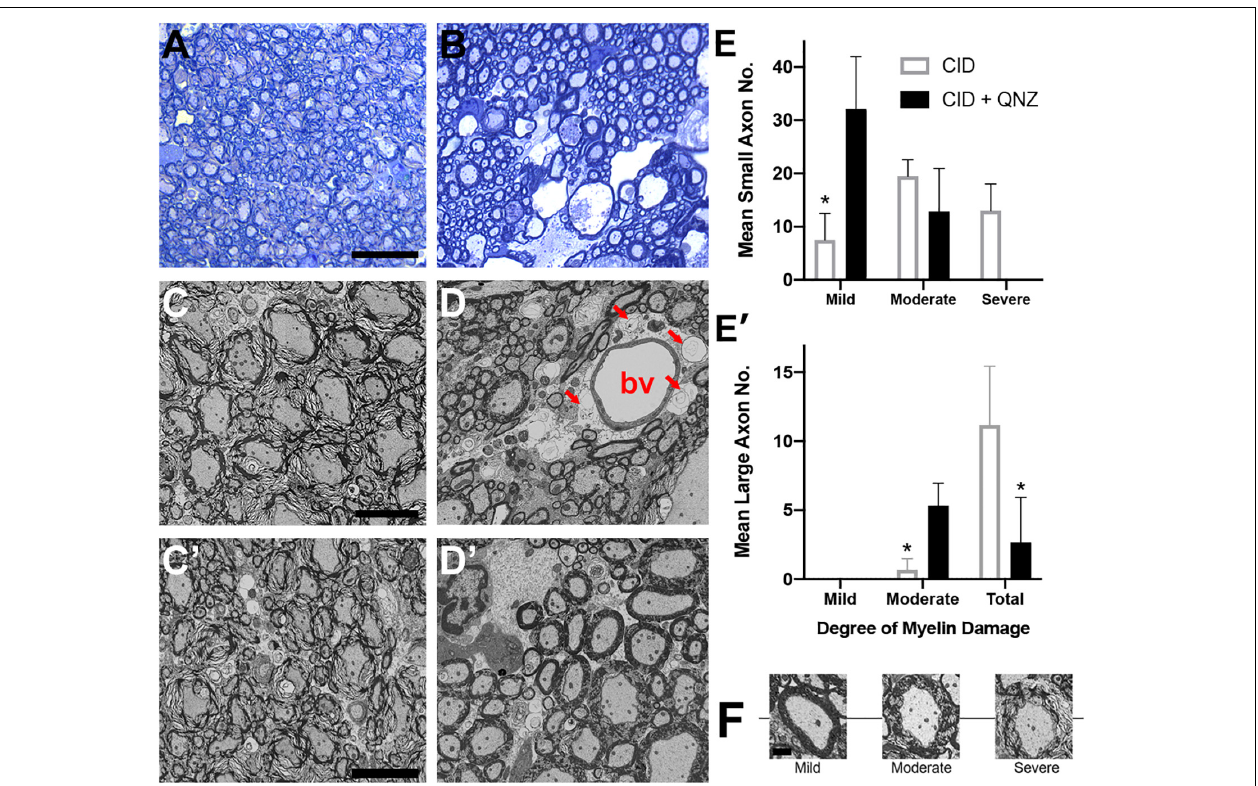
FIGURE 7 | The effects of astrocyte ablation on loss of myelin integrity are reduced by inhibition of NMDA receptors. (A–D) Segments of the GFAP-iCP9 spinal cords affected by local delivery of CID into the ventral white matter show severe disruption of myelin sheath integrity after 24–48 h as demonstrated by Toluidine blue light (A) and EM (C) . By contrast co- injection of QNZ46 provides protection of myelin sheath integrity in the presence of astrocyte loss (B,D) . Note that in (D) although the astrocytes (denoted by arrows) surrounding the blood vessel (denoted by bv ) have been lost in QNZ46 co-injected animals the adjacent myelin sheaths are relatively intact. Large diameter myelin sheaths are less protected than small and medium diameter sheaths (D’) . (E) Quantitation of the relative levels of perturbed myelin sheaths in the presence of CID and CID + QNZ46, from axons of different diameters: Small (E) , and large (E’) . (F) Representative examples of mild, moderate and severely affected axons. Graphs represent mean axon number ± SD. Two-way ANOVA with Sidak’s multiple comparison tests. * indicates p < 0.001. Scale bars: (A,B) 25 µ m; (C,D) 5 µ